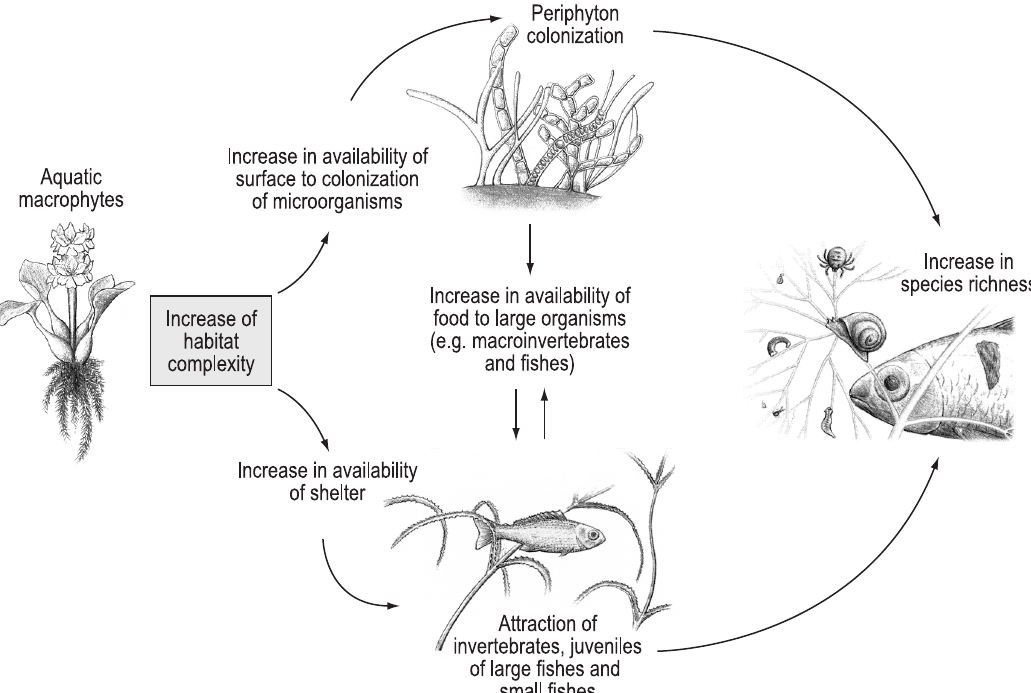
Figure 4. A conceptual model explaining why the structural complexity provided by macrophytes increases the diversity of other aquatic